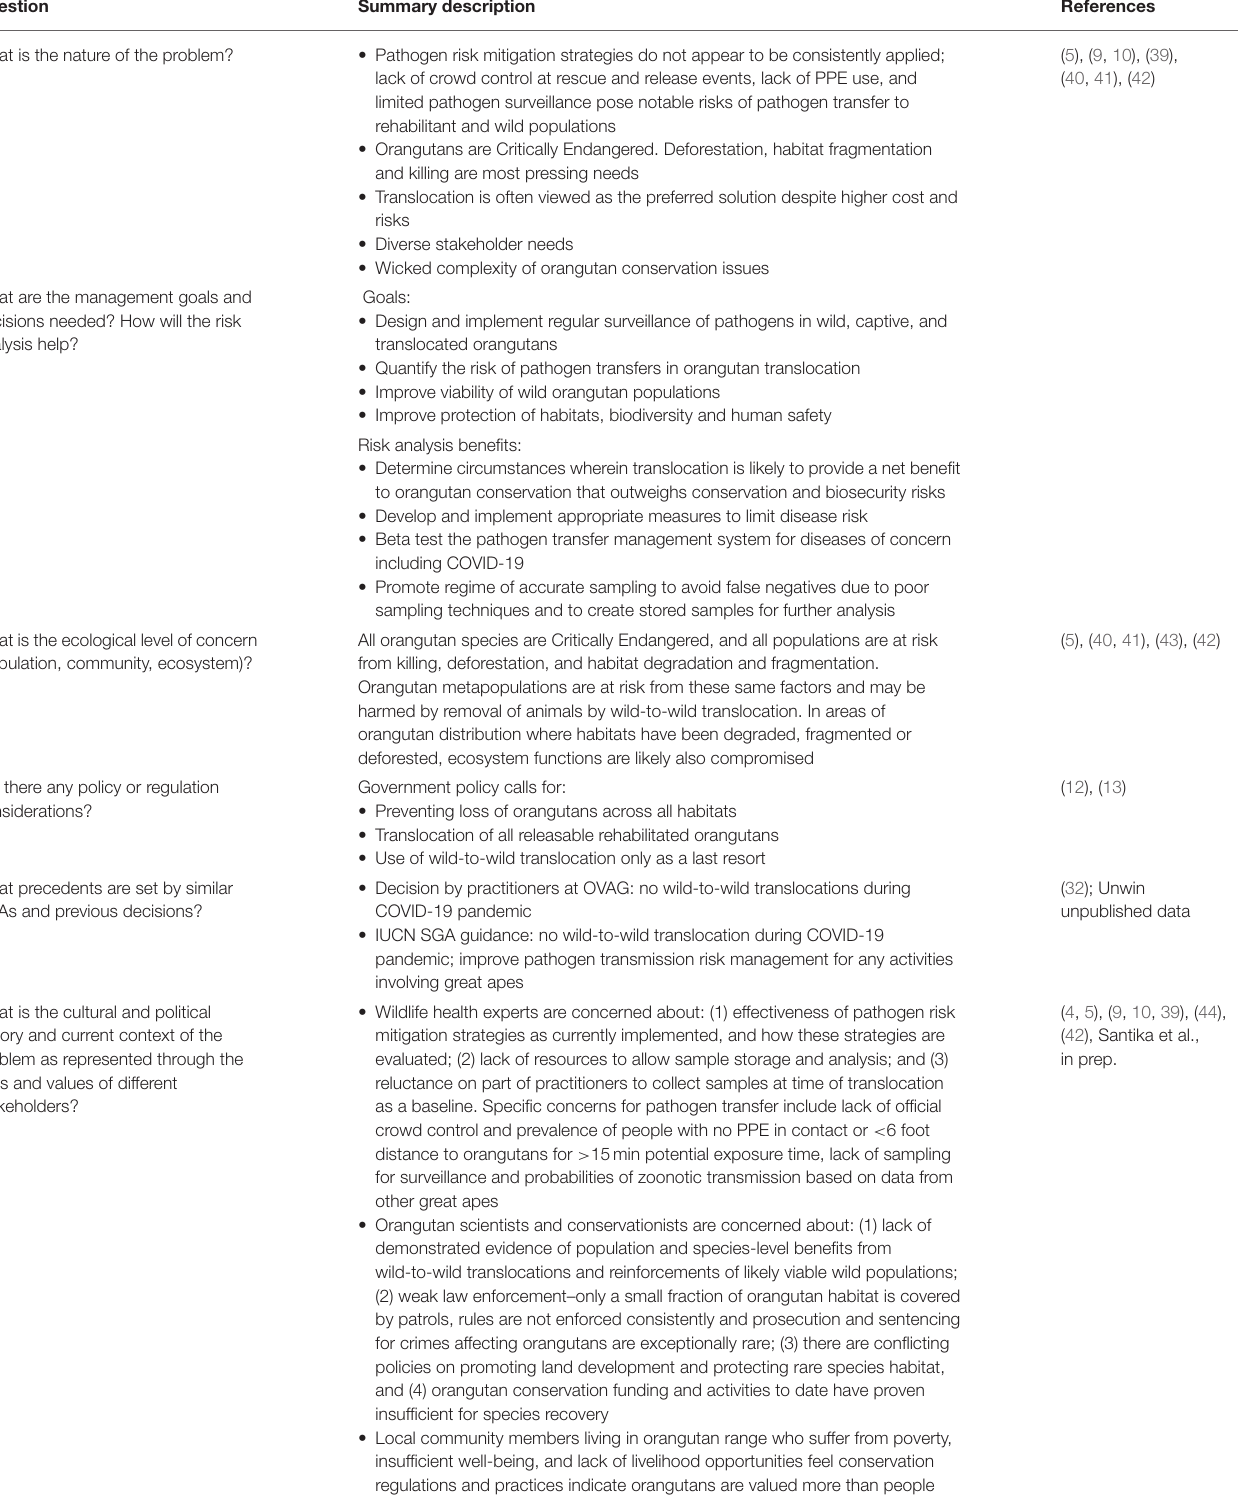
TABLE 2 | Orangutan disease risk problem